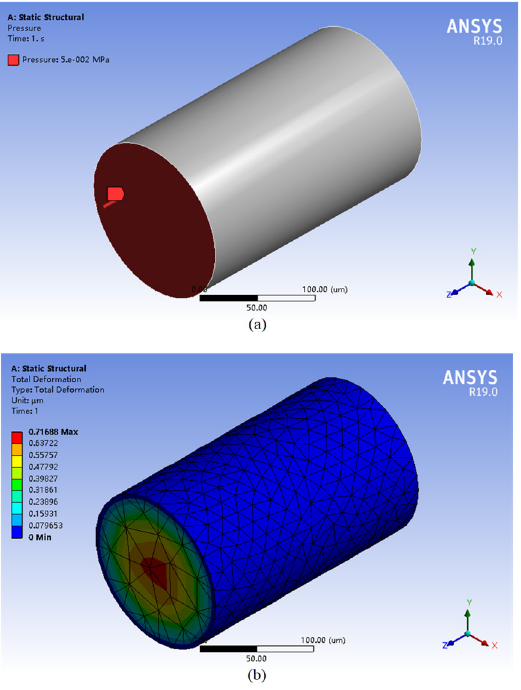
Figure 5. Model building diagram: ( a ) simulation model diagram and ( b ) deformation cloud dia- gram.